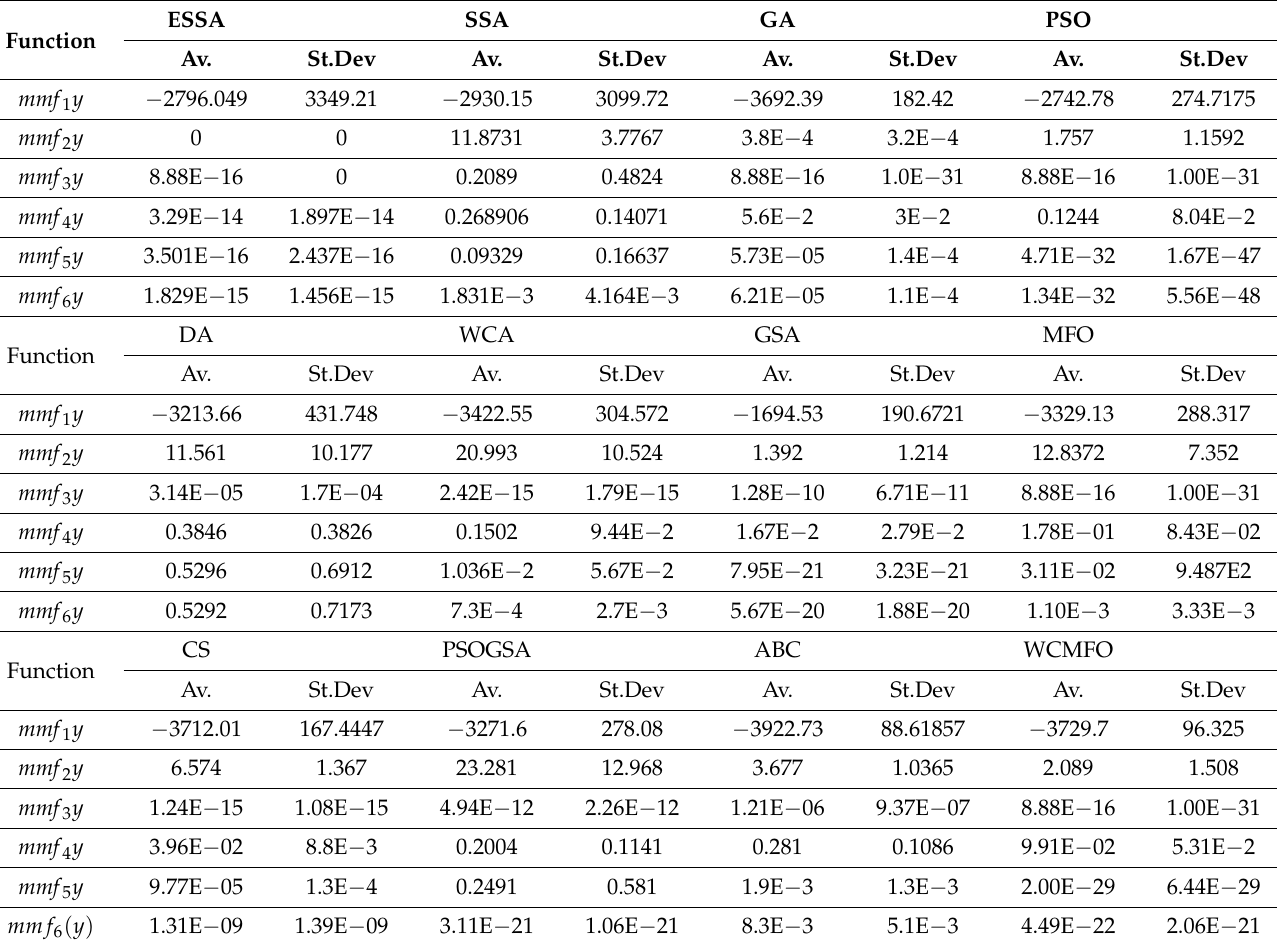
Table 3. Statistical results for 10 dimension functions.